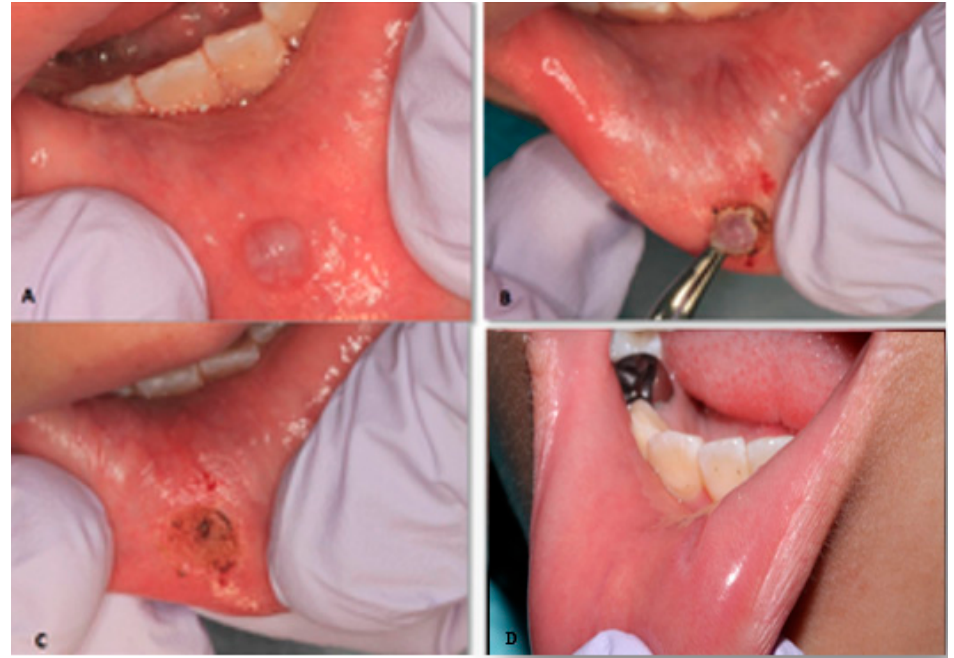
Figure 2. Laser removal of mucocele of the lower lip in an eight years old female. ( A ) Initial clinical presentation of the mucocele. ( B ) Mucocele removal by using high-intensity diode laser. ( C ) Immediate postoperative view. ( D ) Clinical appearance of the removed mucocele after one month.